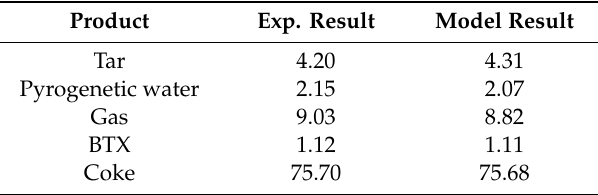
Table 7. The results of the coal blend